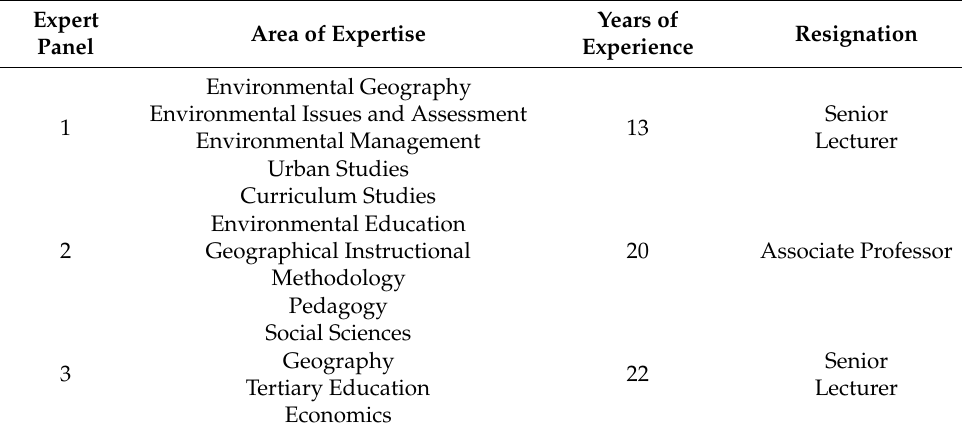
Table 7. External group expert